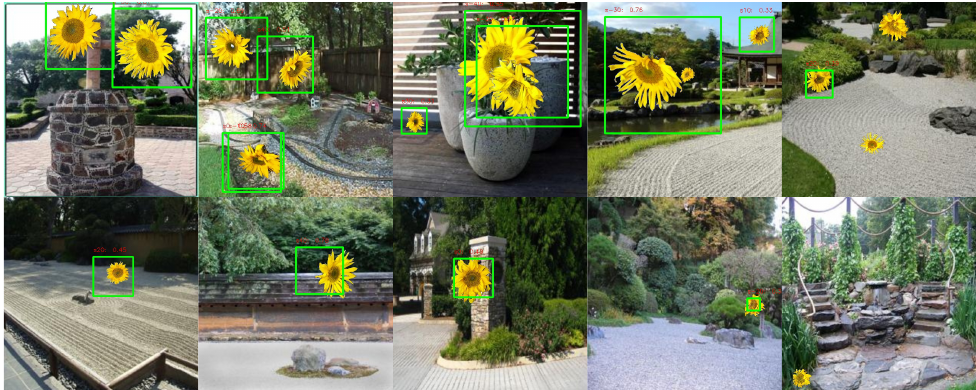
Figure 14. Illustration of detection results both when there are multiple flowers in view ( upper ), and when there is only one flower in view ( lower ). Table 1. Experimental results of different models for flower detection and angle estimation. Model Alpha Factor Resolution Detection AP SSD + MobileNetV1 1.0 320 ×